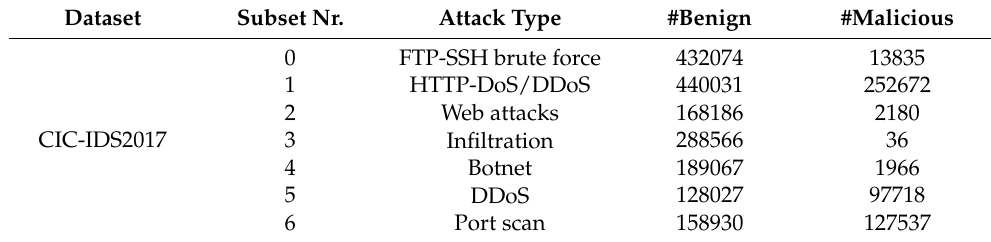
Table 1. CIC-IDS2017 Class Label Distribution.